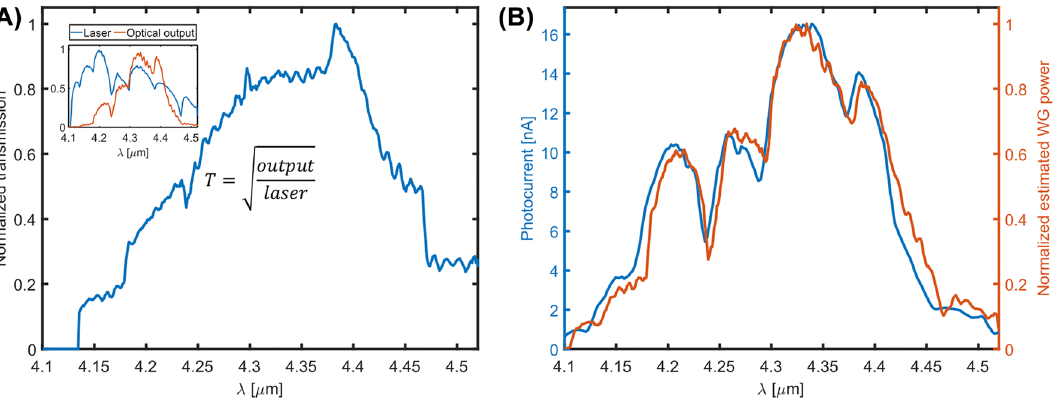
Figure 4: Spectral response of the photodetector. (A) Estimated transmission spectrum of the input grating coupler, equal to the square root of the total transmission of the waveguide. Inset: input and output spectra. (B) Spectra of the photocurrent and the estimated optical power propagating in the